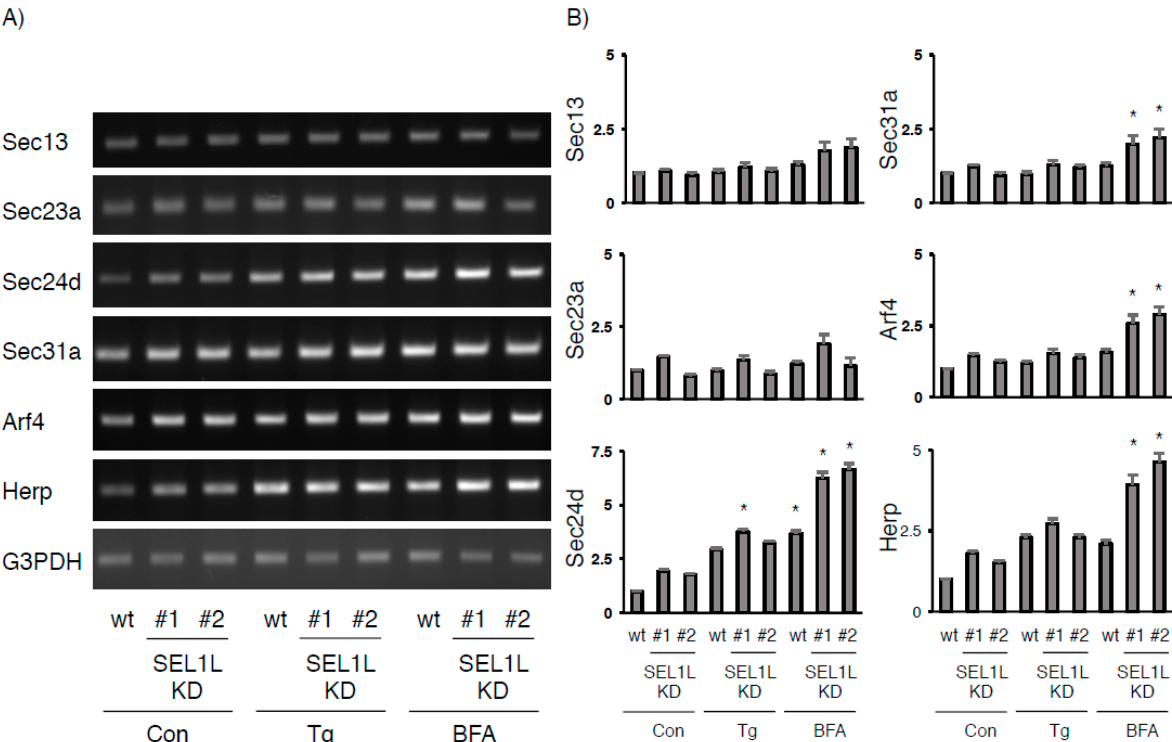
Figure 6. Effects of SEL1L deficiency on CREB3- and CREB3L2-regulated gene expression in HEK293 cells. ( A ) Wild-type (wt) and SEL1L-deficient HEK293 cells were treated with Tg (0.01 µ M), BFA (0.5 µ g/mL), or vehicle for 6 h. The expression of the indicated mRNAs in wt and SEL1L-deficient cells was detected as described in the Materials and Methods. Representative results of four independent cultures are shown. ( B ) The relative amount of each mRNA in wt and SEL1L-deficient cells was evaluated as described in the Materials and Methods. The amount of each mRNA in wt HEK293 cells without treatment was considered “1”. Each value represents the mean ± SEM from four independent cultures. Values marked with asterisks are significantly different from values value of untreated wild-type cells (* p < 0.01).